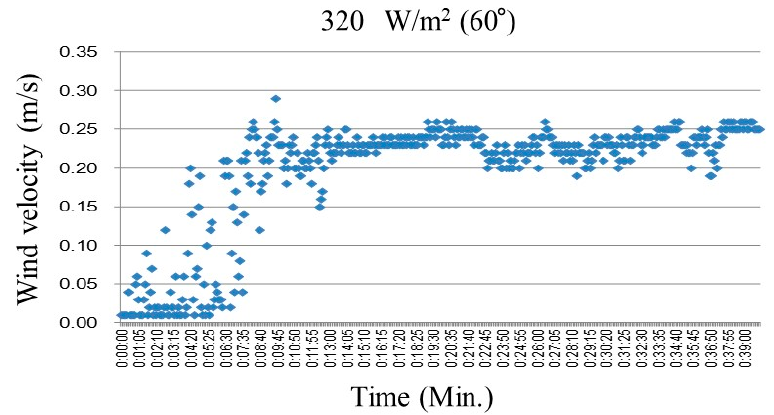
Figure 15. Generated wind velocity in large-scale OPV-solar chimney as a function of time.